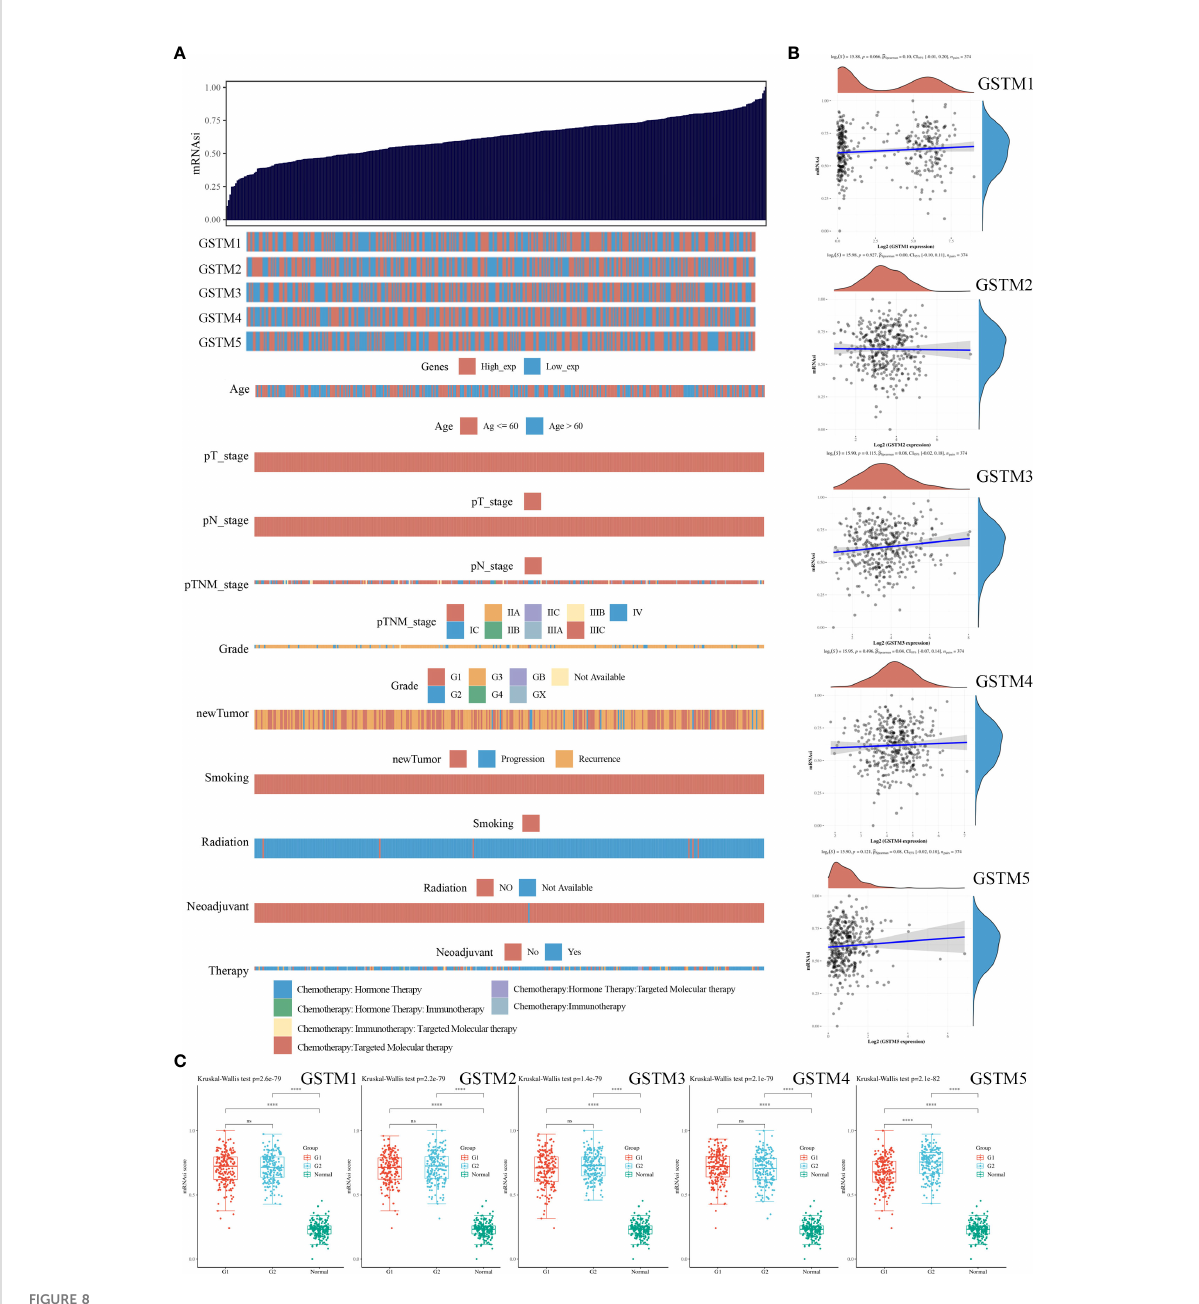
FIGURE 8 The association of stemness features and GSTMs in OC. (A) The stemness score heatmap of GSTM expression and clinical information. The top fi gure is the stemness score from low to high, and the bottom fi gure is the distribution of GSTMs expression and clinical information features after sorting. (B) Correlation analysis of stemness score and GSTMs gene expression. (C) The distribution of stemness scores in high expression of GSTMs OC groups, low expression of GSTMs OC groups, and normal ovary groups. (G1 is the group of the OC patients with high expression of GSTMs. G2 is the group of the OC patients with low expression of GSTMs.) ****p <